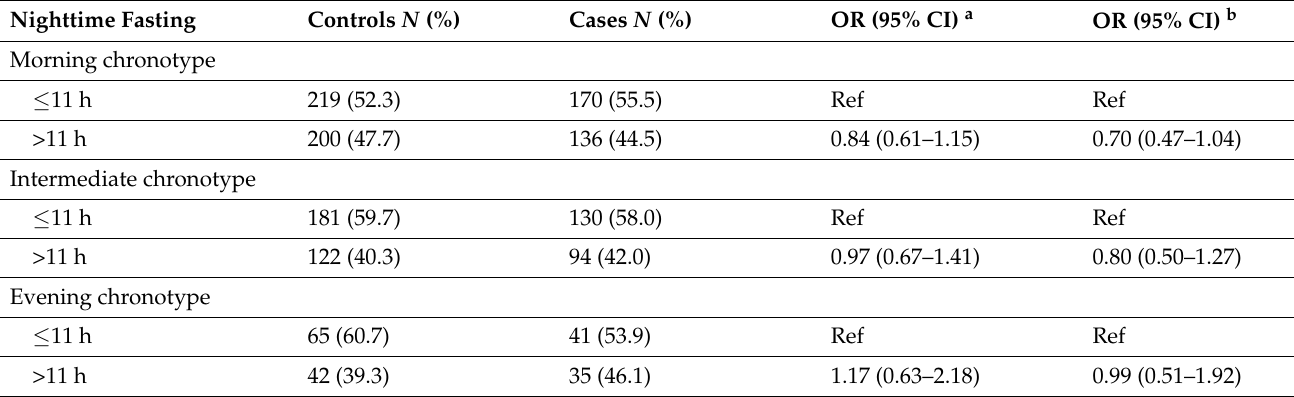
Table 6. Association of nighttime fasting and prostate cancer risk stratified by chronotype (missing for 19 controls and for 1 case).